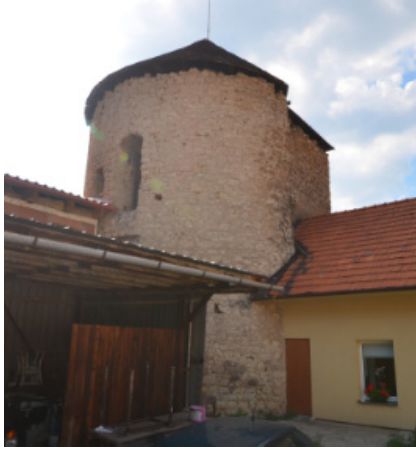
Figure 12. Hussite bastion, exterior view